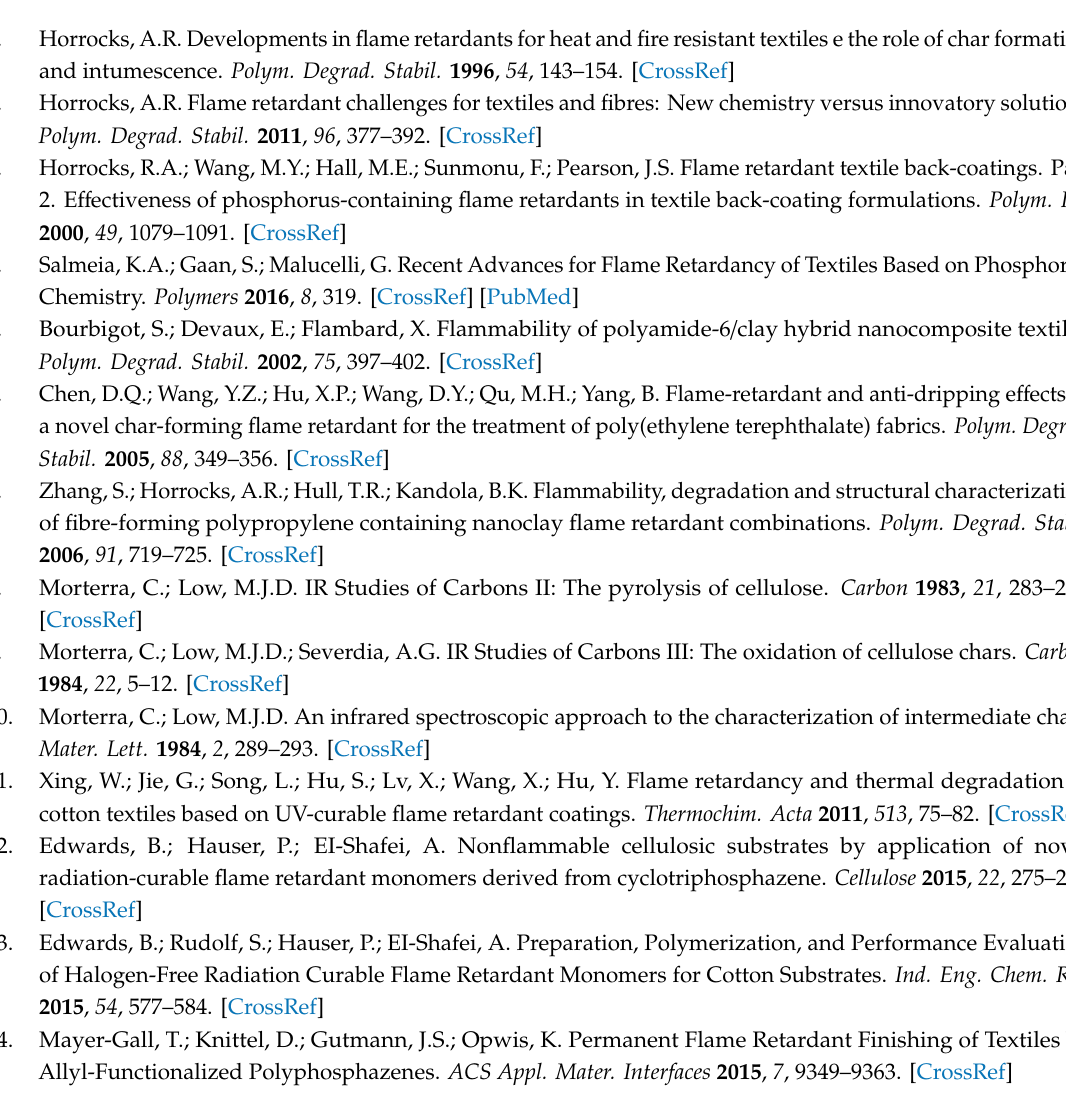
Figure S1: 1 H NMR spectrum of M-G homopolymer, Figure S2: 1 H NMR spectrum of M-C homopolymer, Figure S3: 1 H NMR spectrum of M-G 1 H NMR spectrum of M-G 70 -C 30 copolymer, Figure S4: 60 -C 40 copolymer, Figure S5: 1 H NMR spectrum of M-G 1 H NMR spectrum of M-G 50 -C 50 copolymer, Figure S6: 30 -C 70 copolymer, Figure S7: FT-IR / ATR of PAA homopolymers and copolymers, Figure S8: FT-IR / ATR of cotton untreated and treated with copolymeric PAAs, Figure S9: Snapshots of cotton fabrics treated with (M-G / M-C) 70 / 30 , (M-G / M-C) 50 / 50 and (M-G / M-C) 30 / 70 blends in vertical flame spread